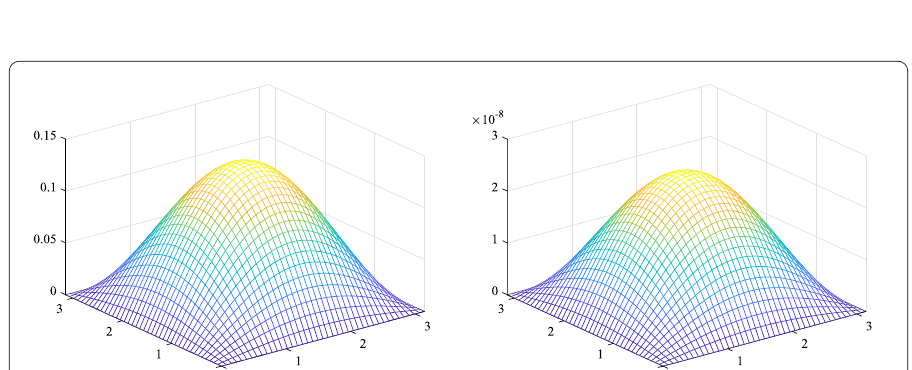
Figure 7 The figure of CFDS6-SSM solution (left-hand side) and error of CFDS6-SSM (right-hand side) when J = 41 and t = 2 for SP 3